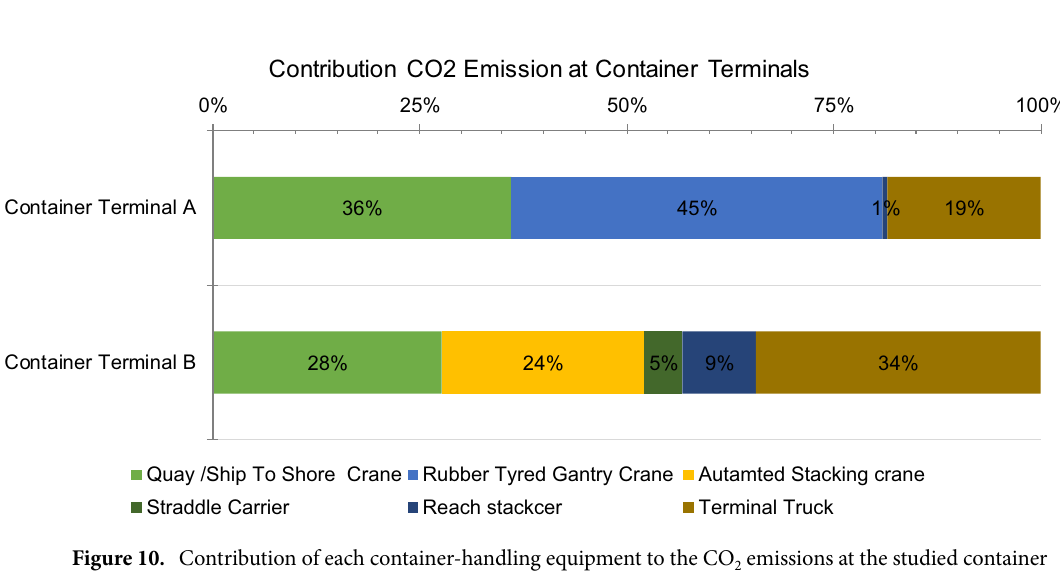
Figure 9. Comparison between the total CO 2 emissions per TEUs at the studied container terminals.